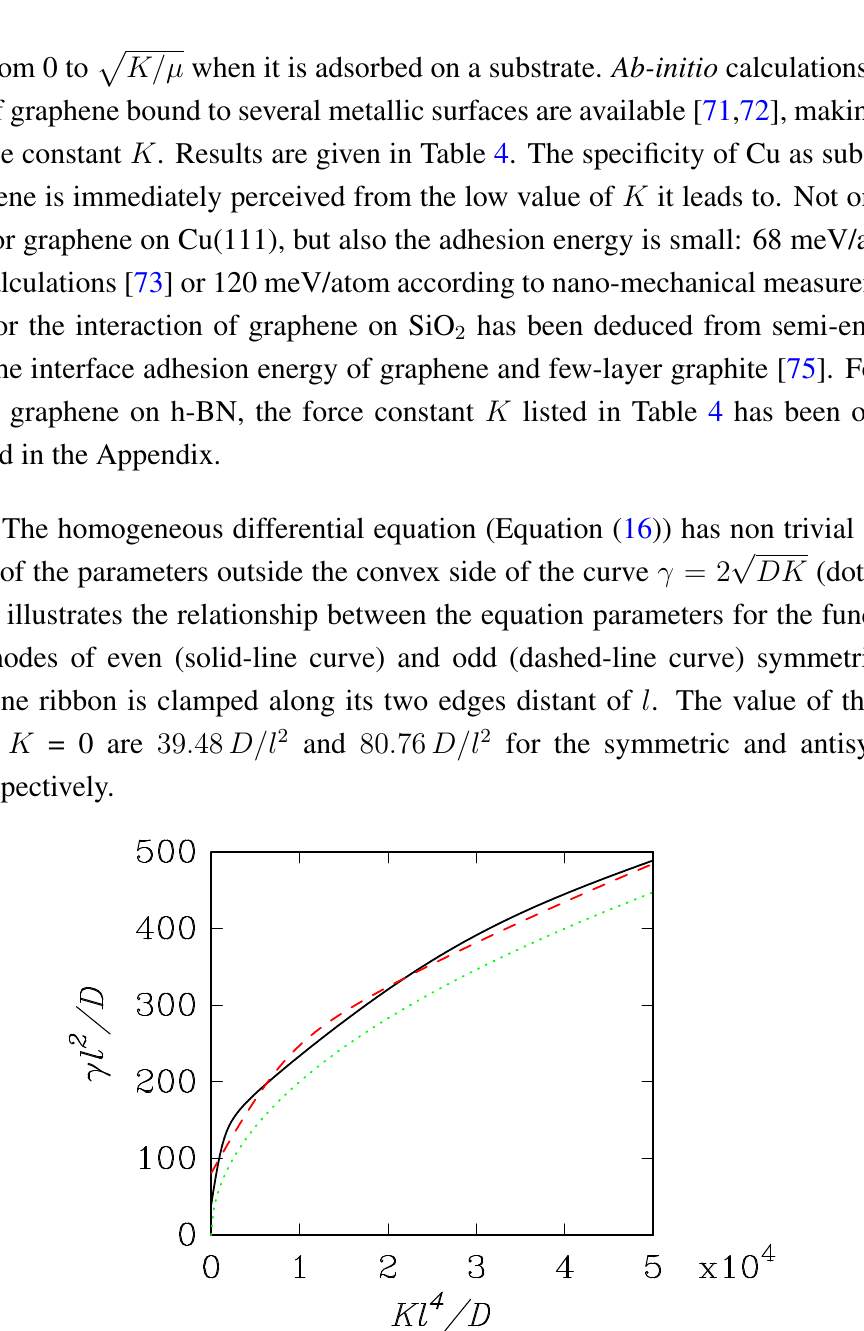
p DK (dotted line).